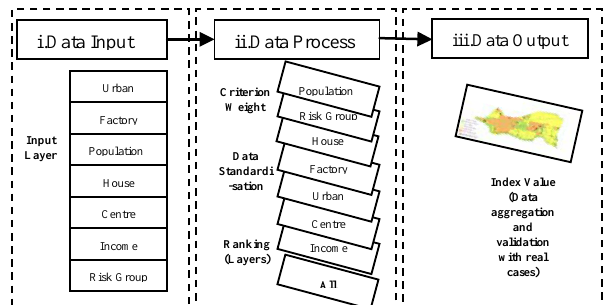
Figure 3. To build a GIS index model with the selection criteria of risk factors of TB risk